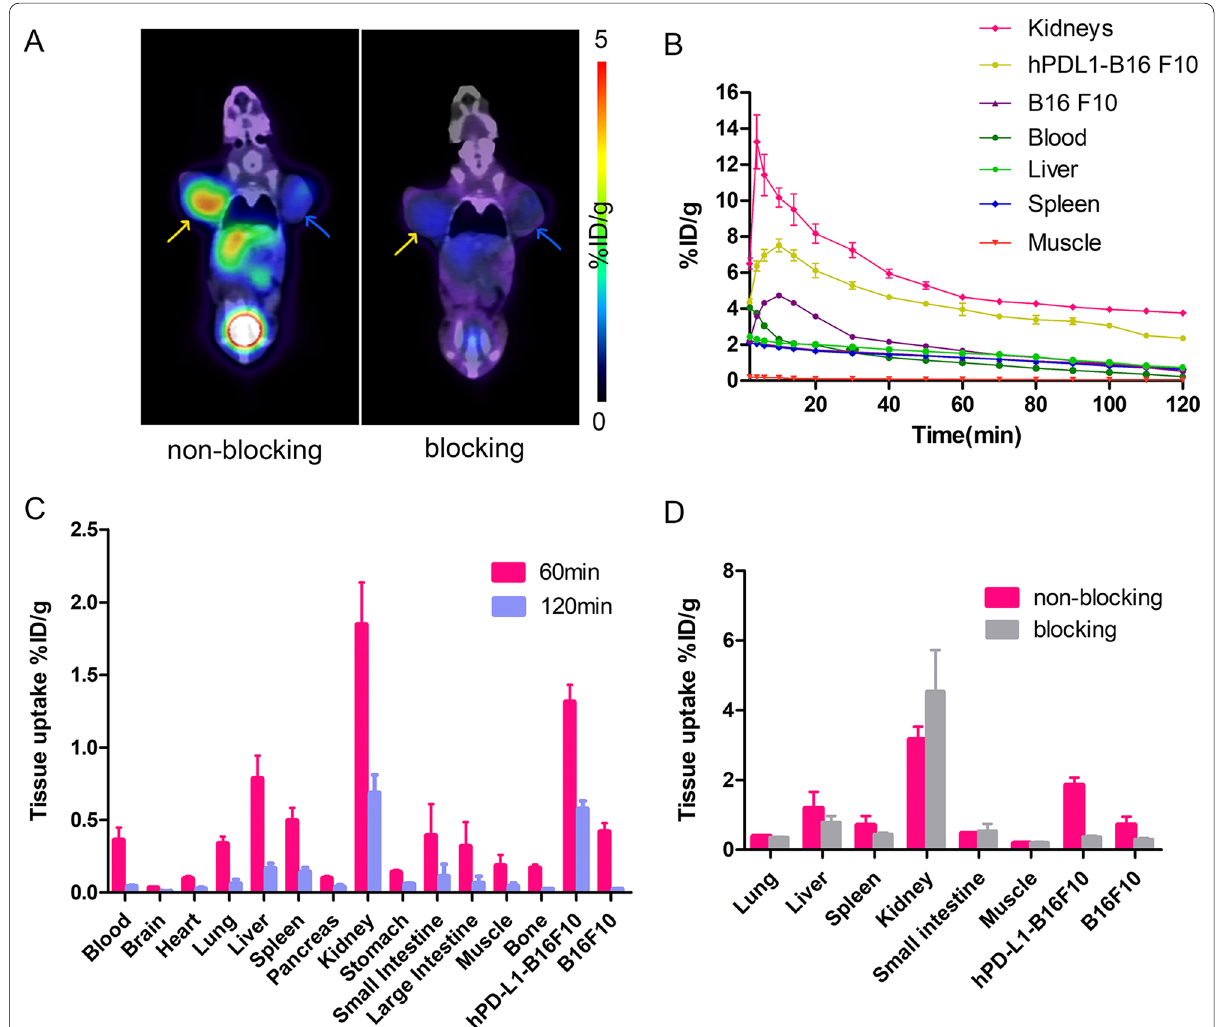
Fig. 3 A Representative coronal slices PET images of two mice bearing bilateral hPD-L1 + hPD-L1-B16F10 (yellow arrows) and hPD-L1 − B16F10 (blue arrows) tumors at 60 min post- 68 Ga-NODAGA-BMS986192 administration. The left images show probe alone; the right images show co-administration of 10 mg/kg ADX_5322_A02; B Representative time-activity curves; C Mice ex vivo biodistribution of 68 Ga-NODAGA-BMS986192, 1 h and 2 h post-injection ( n 5/group); D Mice ex vivo biodistribution of. 68 Ga-NODAGA-BMS986192 1 h post-injection, with and without = co-administration of cold ADX_5322_A02 as a blocking agent ( n =